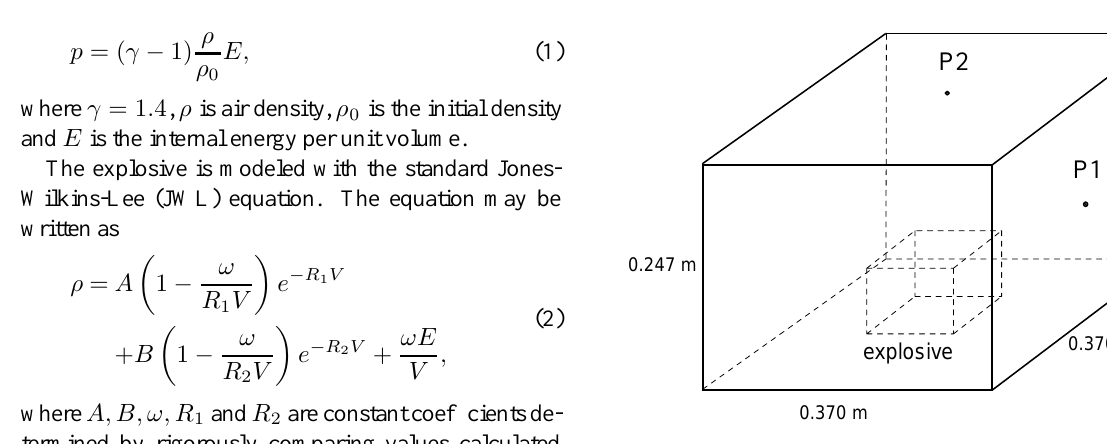
Fig. 1. Explosive in a confined cube